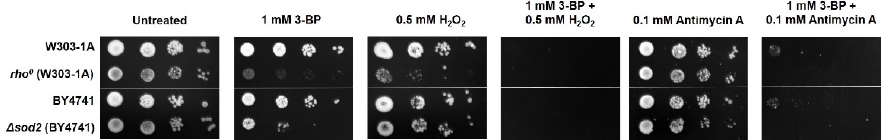
Figure 5. 3-BP causes an increase in mtDNA lesions detected in the QPCR assay. Logarithmically growing WT cells were treated with indicated 3-BP concentrations and 0.1% MMS for 5 h and DNA was extracted from cells. DNA concentrations were adjusted and PCR was run to amplify 6.9 kb fragment of mitochondrial COX1 gene. dsDNA content was measured with QuantiFluor (Promega). PCR products were visualized with agarose gel electrophoresis. * p ≤ 0.05; ** p ≤ 0.01; *** p ≤ 0.001.